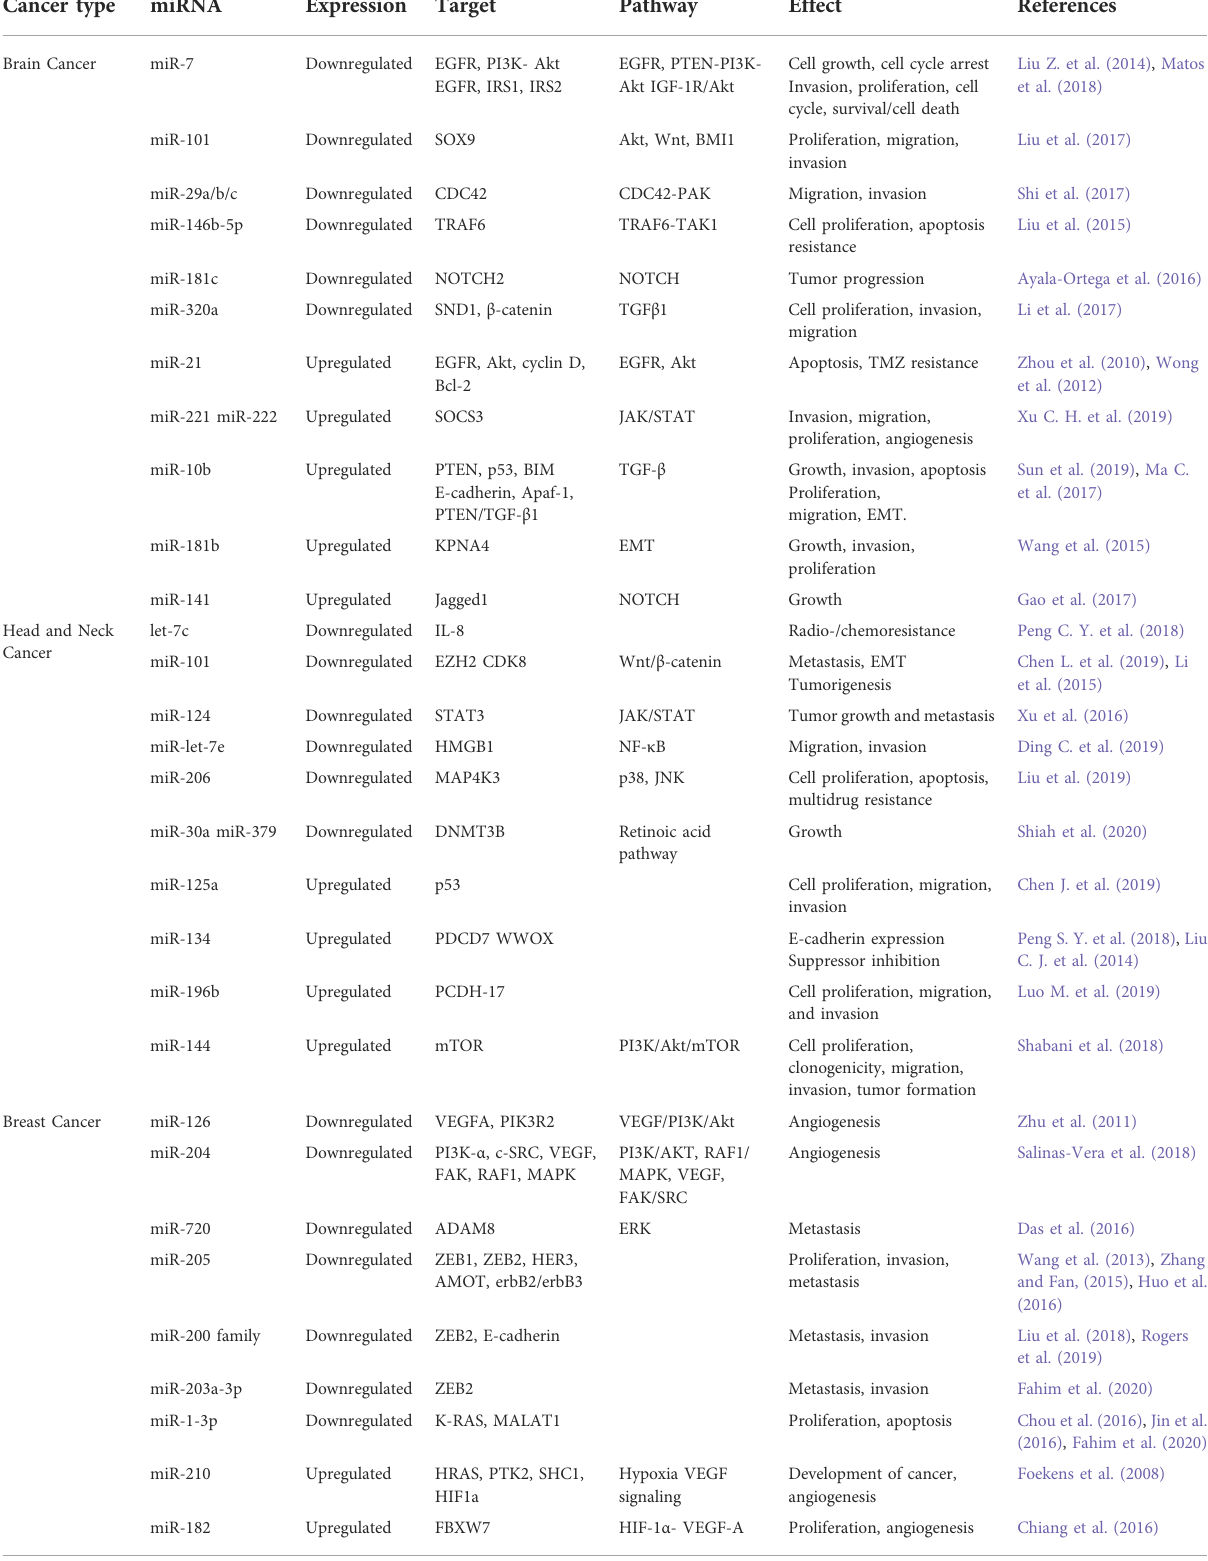
TABLE 1 Examples of miRNAs and their roles in different cancers. Cancer